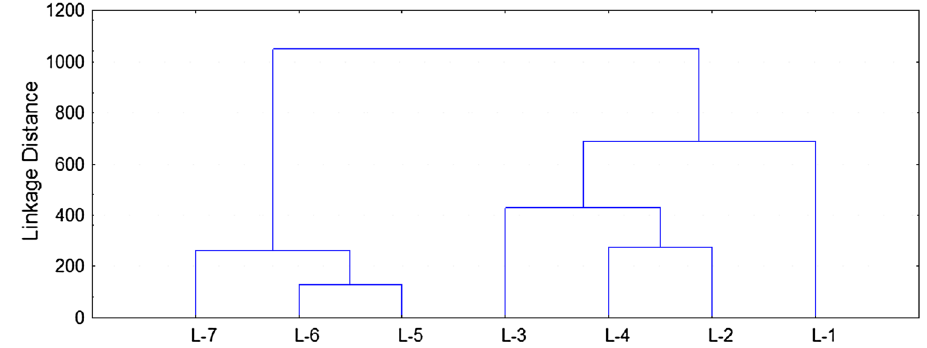
Fig. 2 Dendogram derived from Ward’s method of 7 sites based on physicochemical